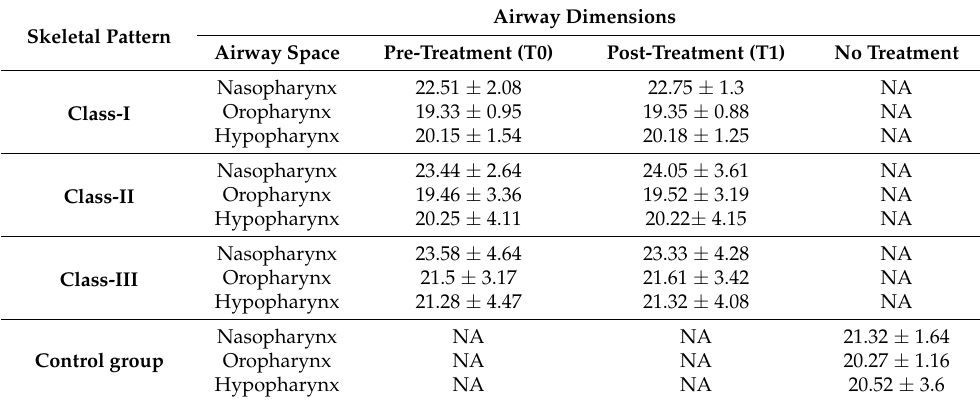
Table 2. Pre- and post-treatment airway dimensions (mean ± standard deviations) among controls and patients with skeletal class-I, -II and -III